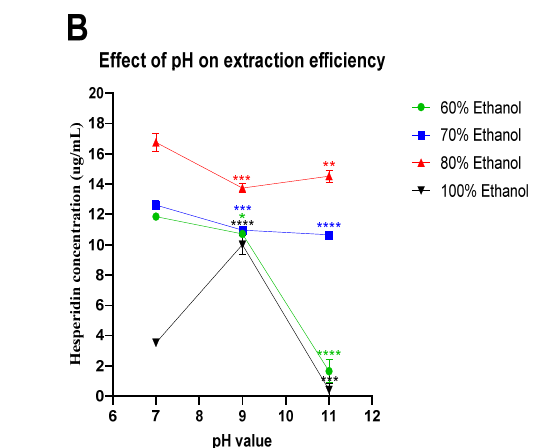
Figure 3. Effect of temperature on extraction efficiency. Limonin ( A ) and hesperidin ( B ) concentra- tions in the ethanolic-aqueous extracts of lime peel after extraction with 60% ( ● ), 70% ( ■ ), 80% ( ▲ ), and 100% ( ▼ ) ethanol in water with the specified temperatures, at pH 7 for 100 min. The statistical differences were separately analyzed for limonin and hesperidin by using one-way ANOVA fol- lowed by Tukey’s multiple comparisons test. * , **, *** and **** mean p < 0.05, < 0.01, < 0.001 and < 0.0001, respectively, compared with the concentrations of limonin or hesperidin at 50 °C of each specified condition.